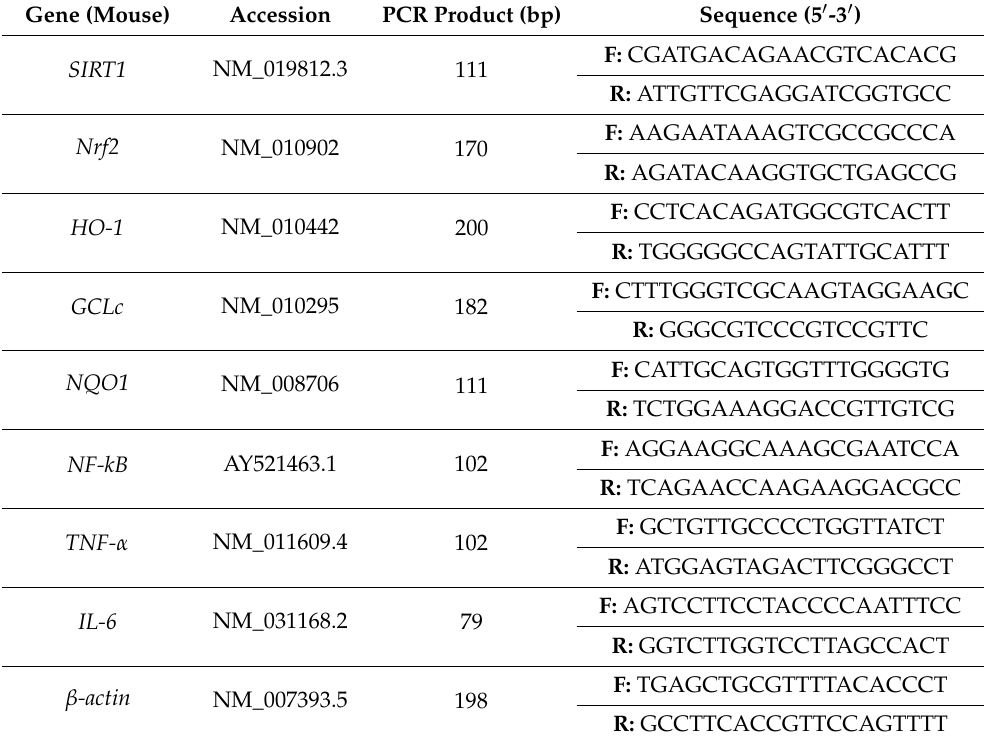
Table 1. The sequence of the primers employed in